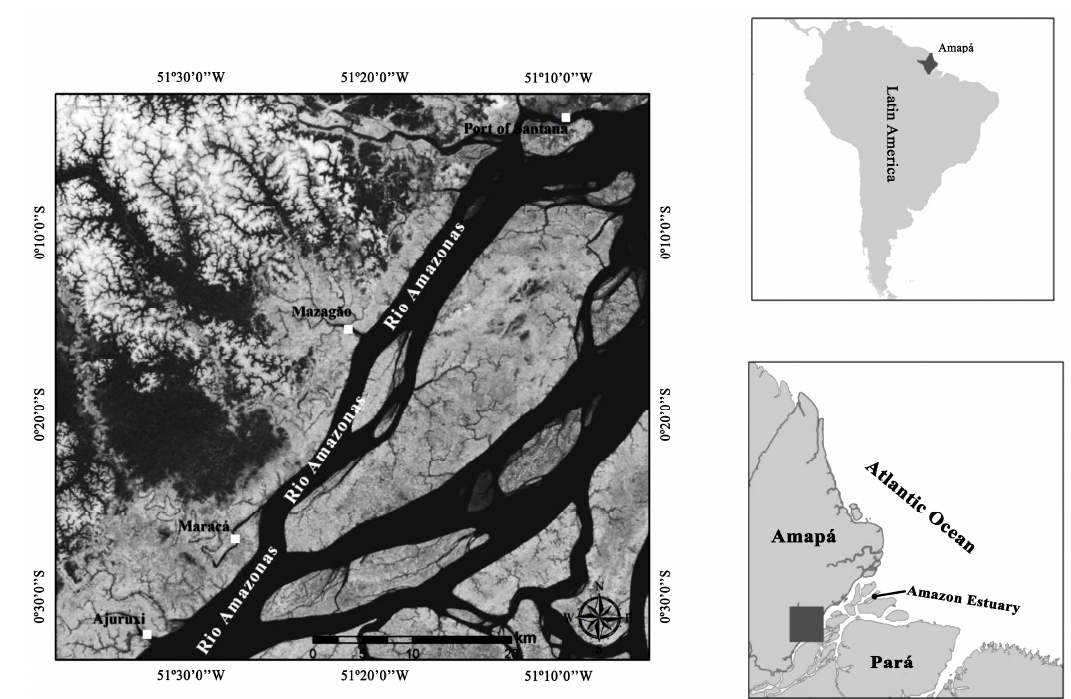
Figure 1. Location of the study area in the southeast of Amapá, in the Brazilian Amazon.